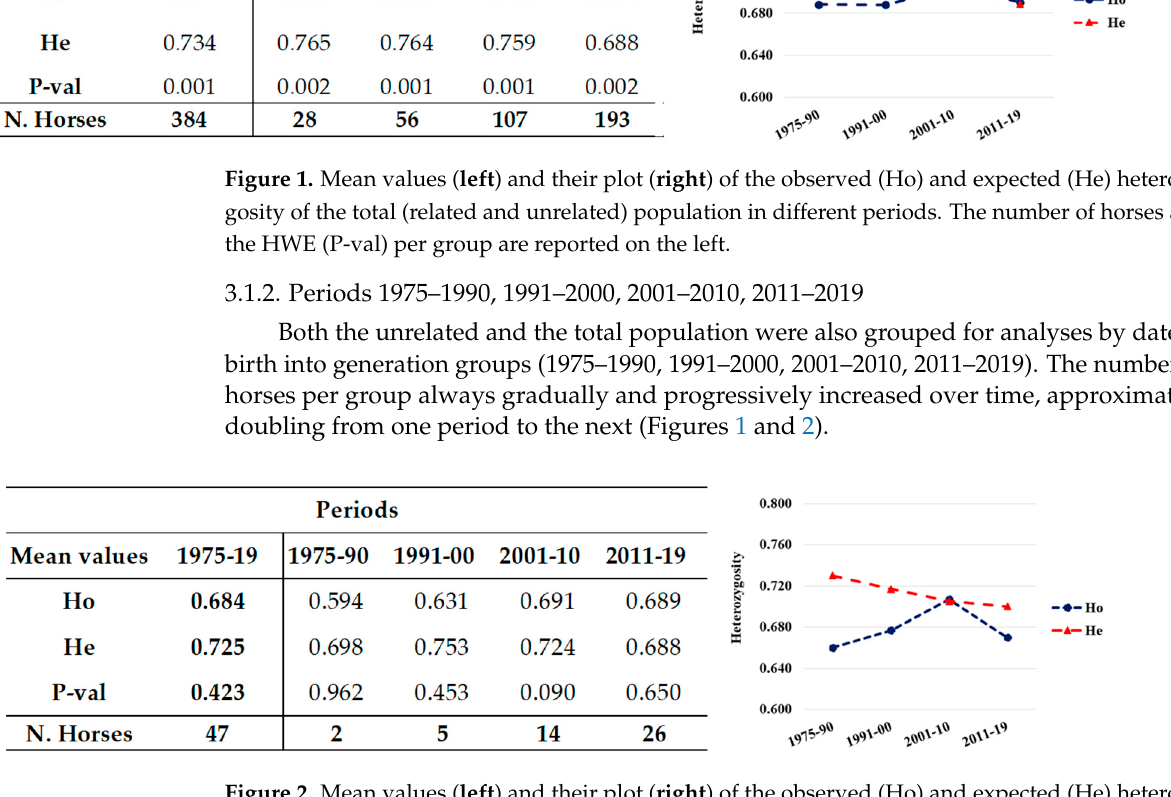
Table 2. Mean F is , values in the total population (related and unrelated) and the unrelated horses in different periods.